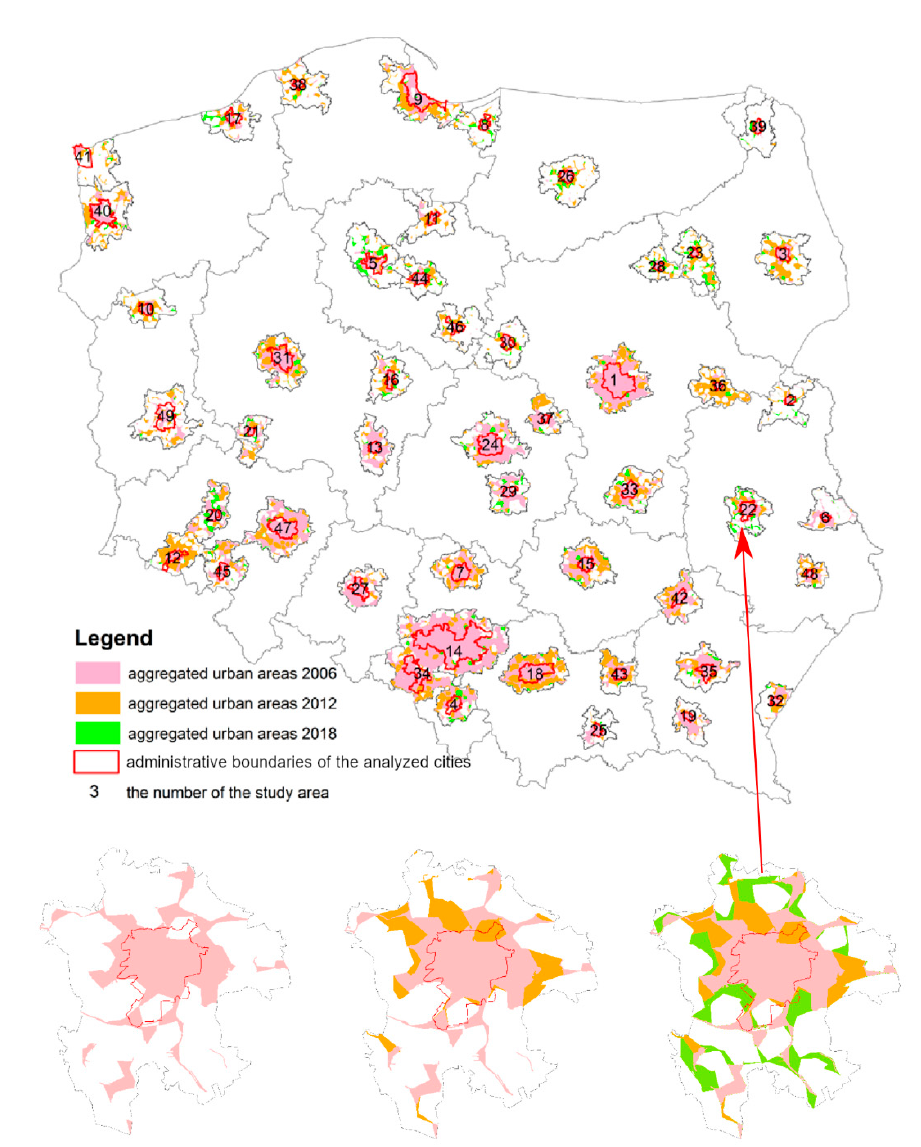
Figure 6. Aggregated urban areas. Source: own elaboration.